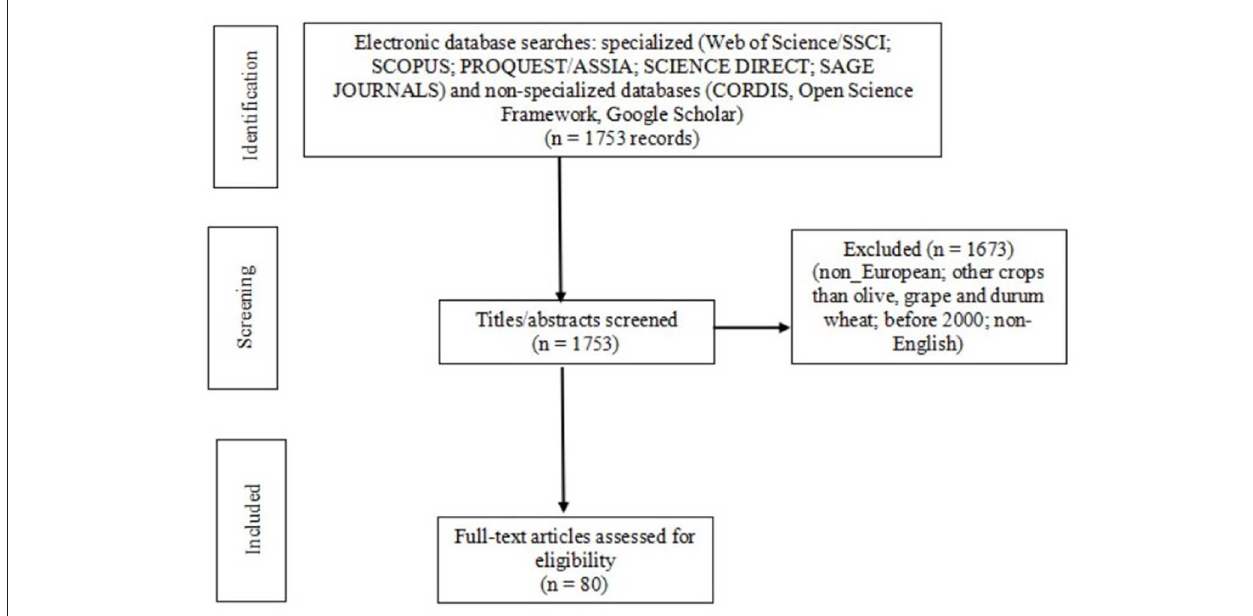
FIGURE 1 | PRISMA flow diagram systematic review detailing the database searches, the number of abstracts screened and the full texts retrieved.